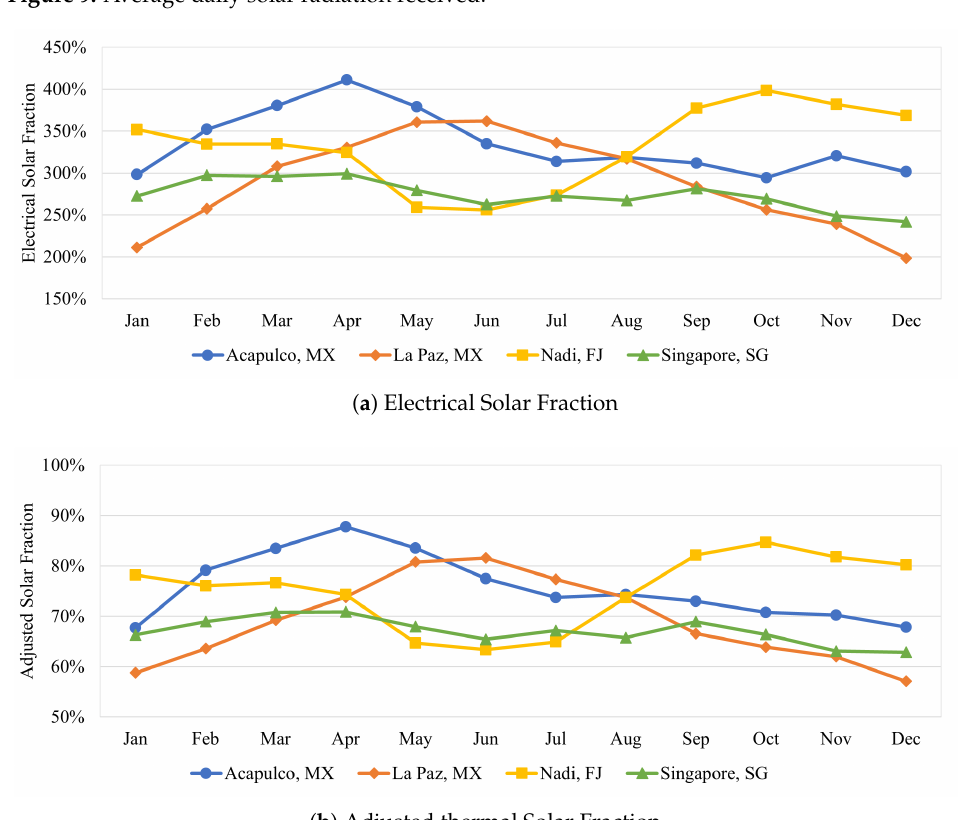
Figure 10. Monthly solar fraction of CPVT-VMD system under different weather